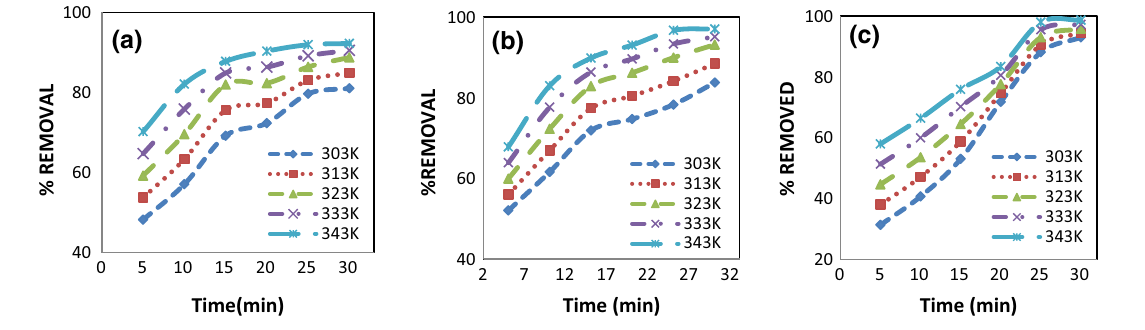
Fig. 1 Effect of solution temperature on CVD adsorption by a LBM, b Mn-LBM, c